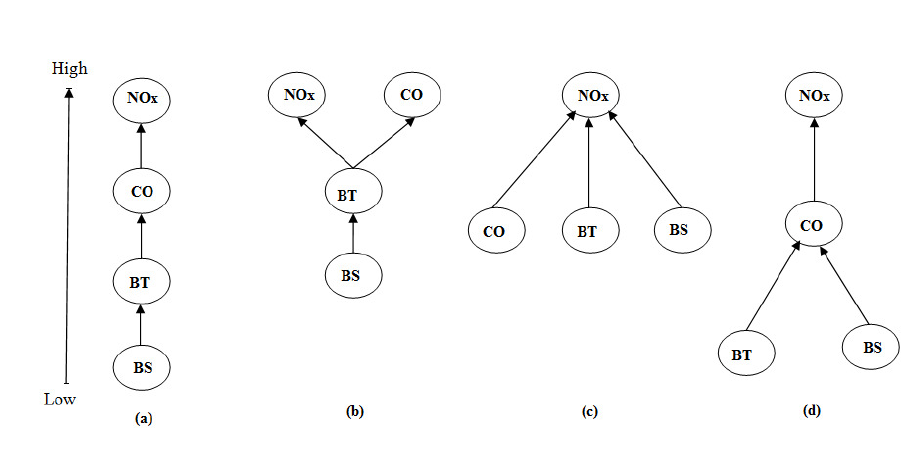
Figure 2. Preference